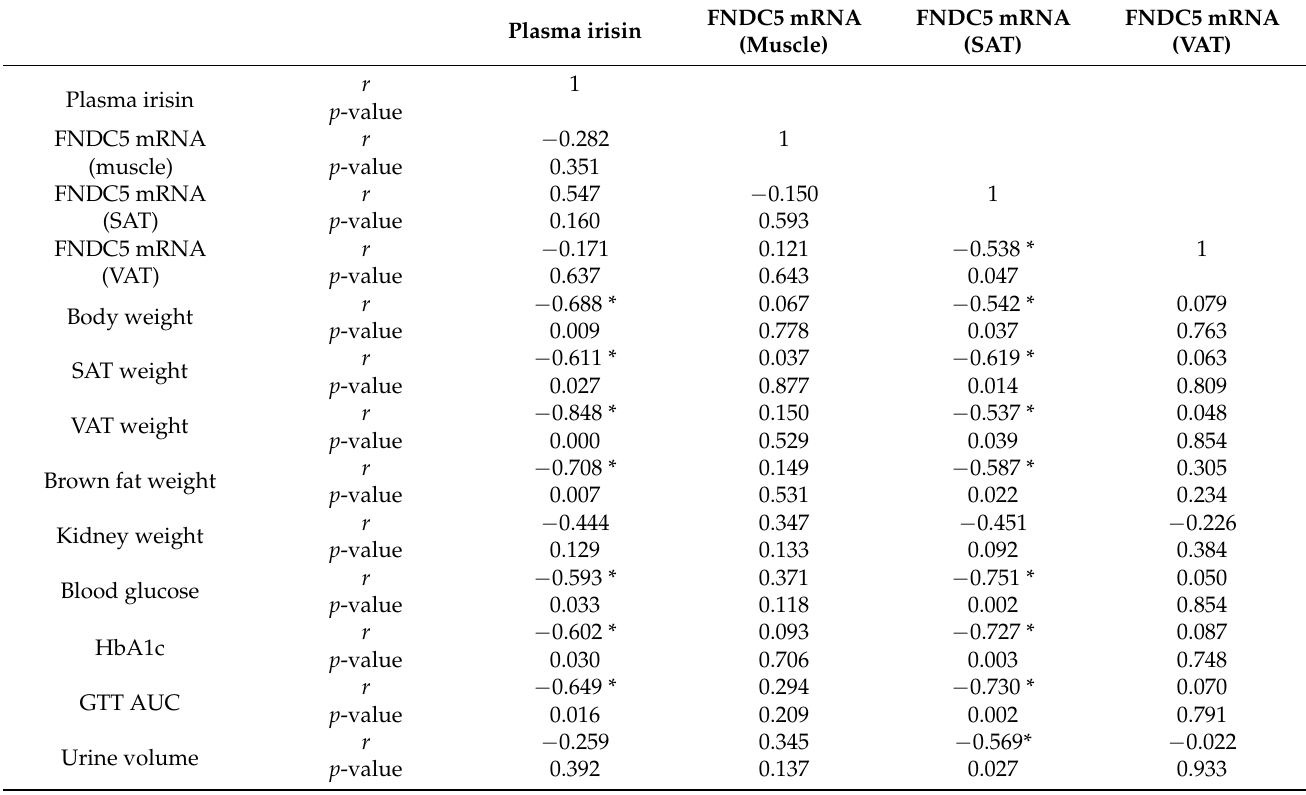
Table 4. Correlation between plasma irisin, FNDC5 mRNA, and metabolic parameters in db/db mice. Plasma